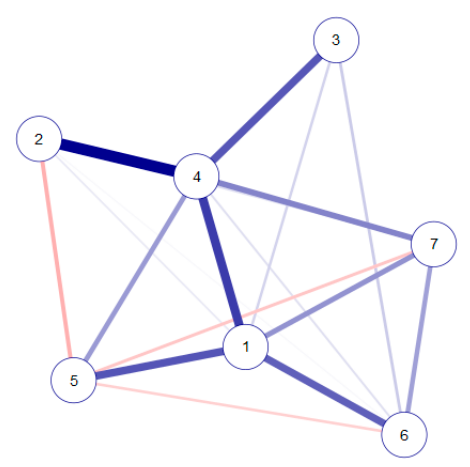
Figure 2. The network plot of the similarity (significant only) between sampling points data of the Sasyk Reservoir in August 2018. The names of sampling stations correspond to Table 1 and Figure 1. The line thickness between stations reflect the correlation value, blue is positive, red is negative.